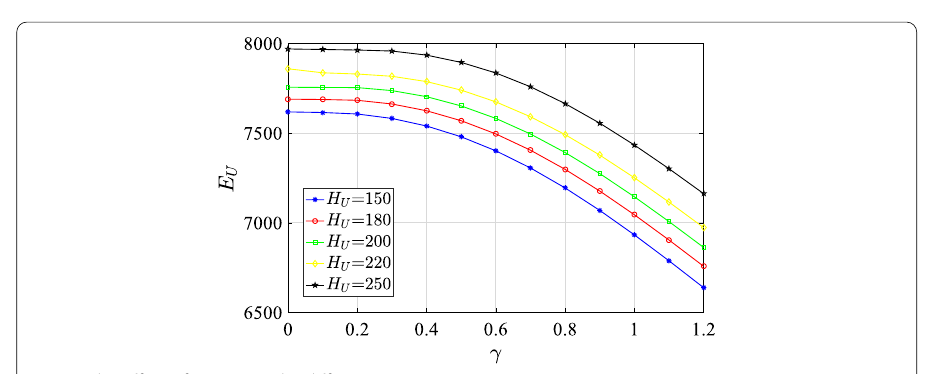
Fig. 4 The effect of γ on E U under different H U